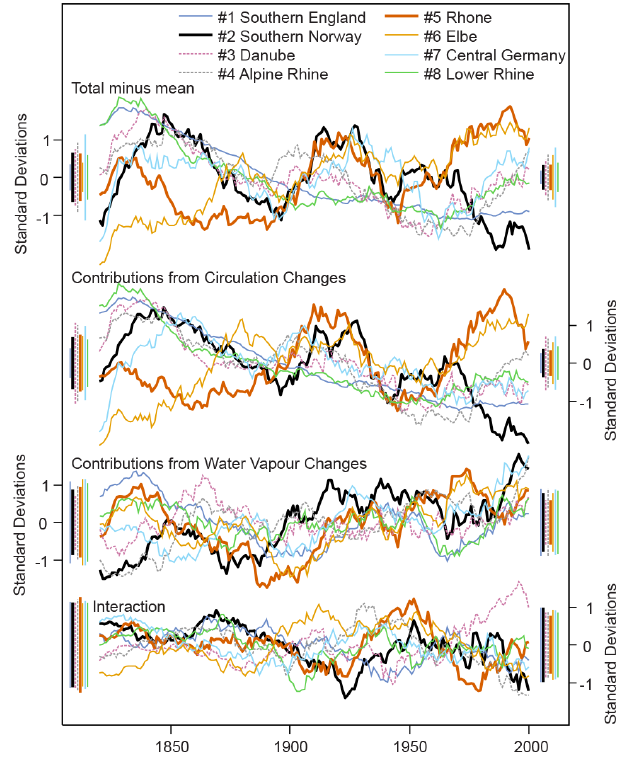
Figure 7. CONV5d (total minus mean) and contributions to it from circulation changes, water vapour changes, and their interaction for each of the eight regions (ensemble mean). All series were stan- dardized and smoothed with a 30-year moving average. Coloured bars indicate ± 1 ensemble standard deviation at the beginning and end of the period. (The change in-between is close to